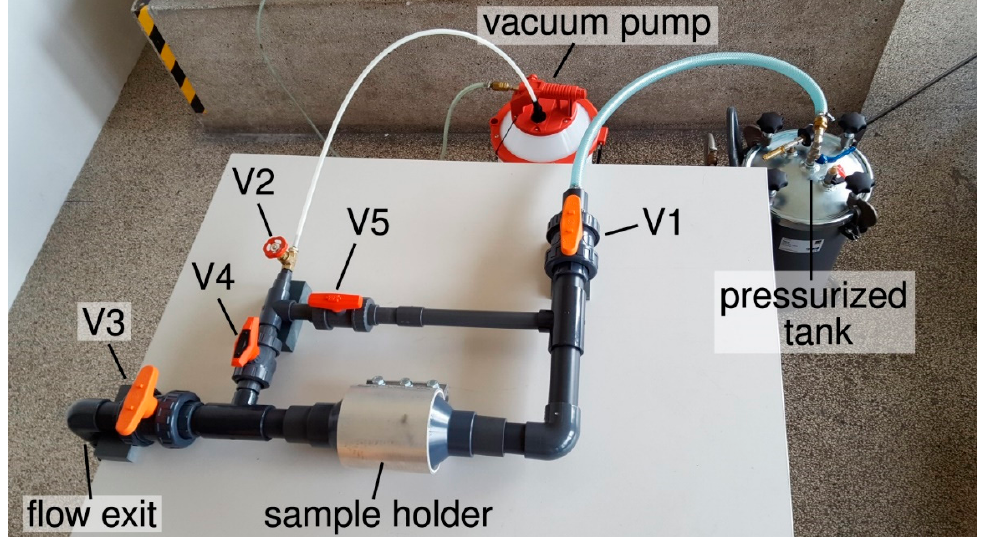
Figure 4. Experimental set-up of the permeability measurements. The scaled sample is installed in different orientations in the sample holder.